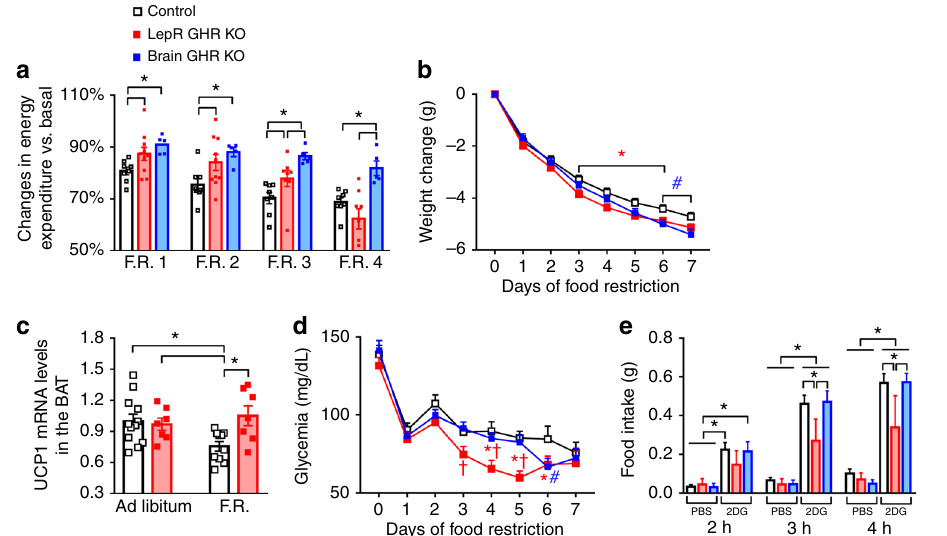
Fig. 6 Central ablation of growth hormone receptor (GHR) prevents energy-saving adaptations during food restriction (F.R.) a Reduction in energy expenditure (VO 2 ) during the days of F.R. compared to baseline (F.R. 1, F (2,20) = 4.792, P = 0.0199; F.R. 2, F (2,20) = 4.707, P = 0.0212; F.R. 3, F (2,18) = 8.695, P = 0.0023; F.R. 4, F (2,18) = 9.151, P = 0.0018; n = 5 – 10). b Body weight changes during F.R. (main effect of F.R. [ F (7,315) = 1011, P < 0.0001], main effect of GHR ablation [ F (2,45) = 2.258, P = 0.1163] and interaction [ F (14,315) = 3.189, P = 0.0001]; n = 14 – 20; * P < 0.05, LepR GHR KO vs. control mice; # P < 0.05, brain GHR knockout (KO) vs. control mice; Fisher's least signi fi cant difference (LSD) post-hoc test). c UCP-1 mRNA expression in the brown adipose tissue (BAT; main effect of F.R. [ F (1,32) = 1.374, P = 0.2499], main effect of GHR ablation [ F (2,32) = 3.646, P = 0.0652] and interaction [ F (2,32) = 5.547, P = 0.0248]) of LepR GHR KO mice. d Blood glucose changes during F.R. (main effect of time [ F (7,315) = 65.76, P < 0.0001], main effect of